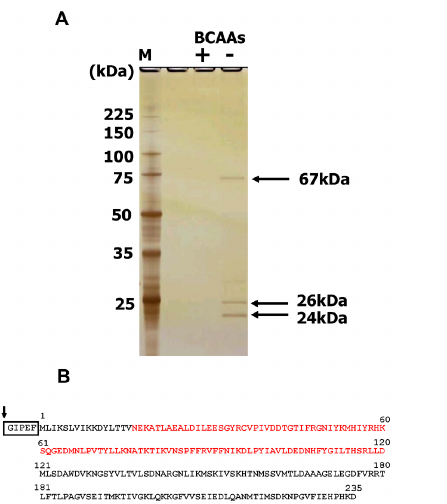
Figure 1. Affinity purified proteins from L. helveticus CM4 eluted from DNA-sepharose. DNA binding proteins purified by DNA-sepharose, which was bound to an approximately 300 bp DNA fragment corresponding to the upstream region of 6 proteolytic genes, were analyzed by SDS (5–15%)-PAGE as described in Materials and Methods (A). Proteins were eluted with buffer containing 10 mM BCAAs (Val, Leu, Ile) ( + ) or no BCAAs ( 2 ). The gel was silver stained after electrophoresis. The molecular masses of the marker proteins (lane M) are given on the left. Schematic drawing of the glutathione S- transferase (GST) fused 26 kDa cystathionine ß-synthase (CBS) domain protein is shown (B). The C-terminal GST protein is shown in the box. The arrow indicates the cleavage site for Factor Xa. Red letters indicate two tandem CBS domains (CBS pair) in the 26 kDa protein.